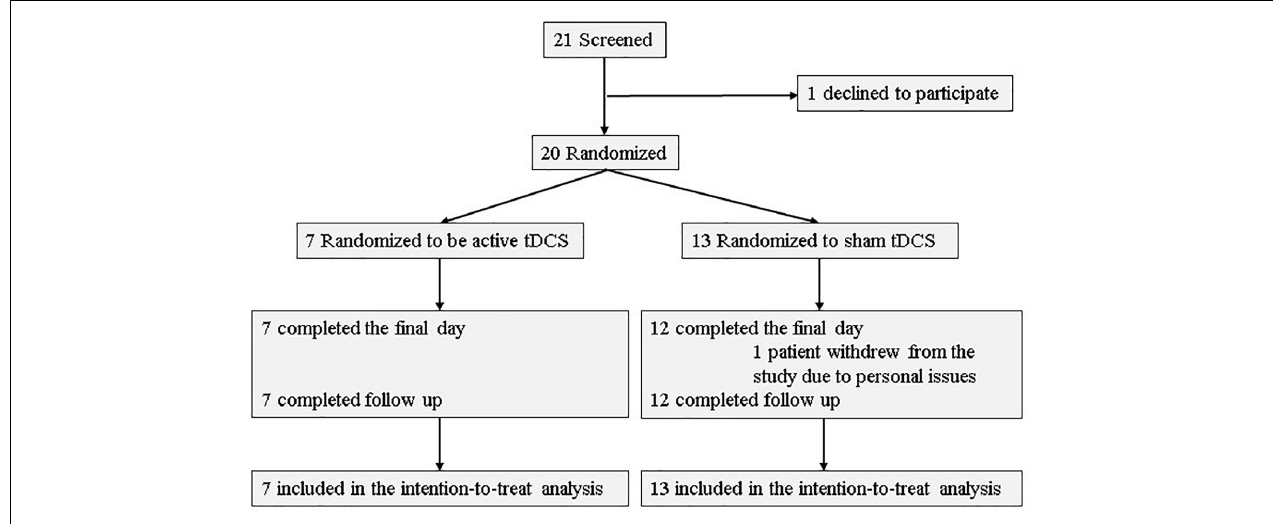
FIGURE 2 | Flow chart of participant selection.